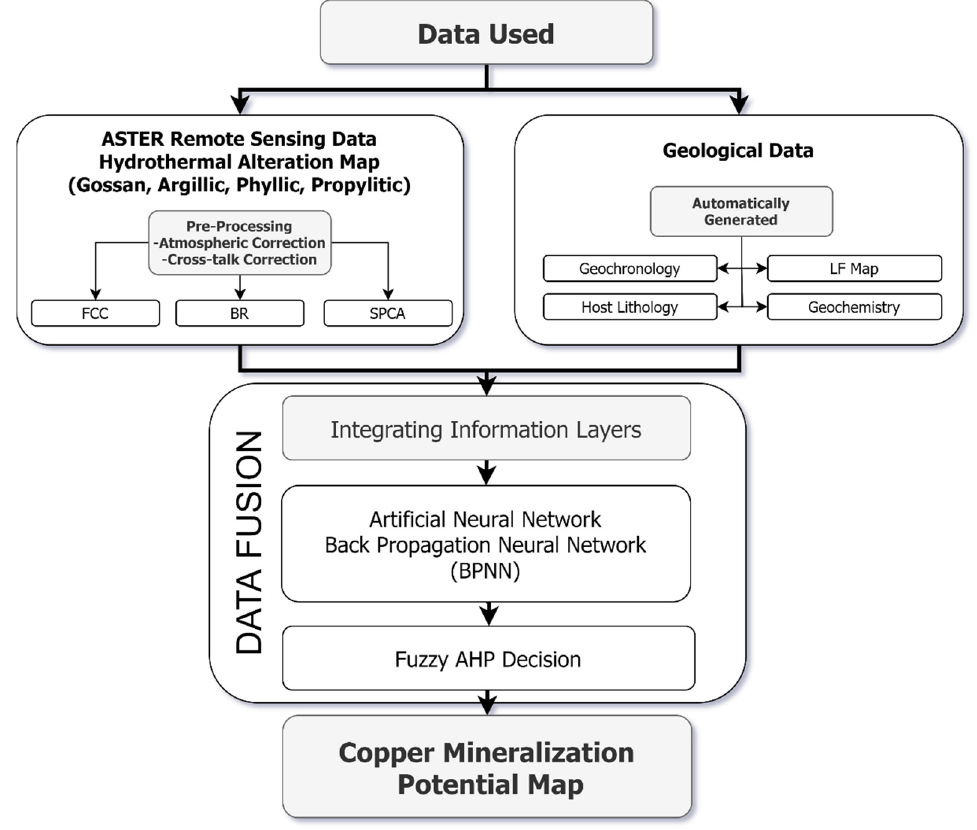
Figure 2. The methodological flowchart implemented in this study.